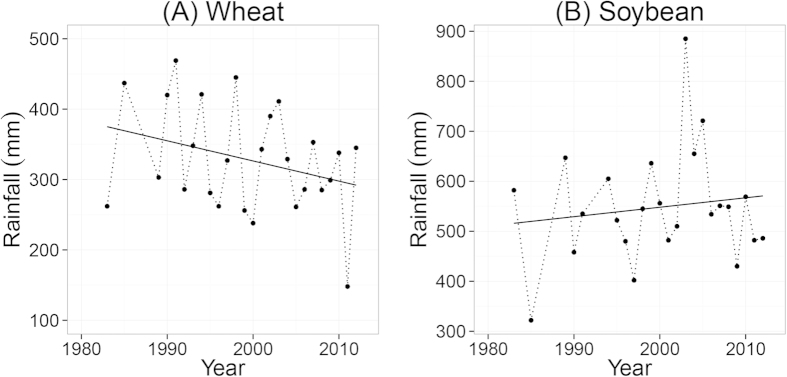
Total rainfall of the growing seasons of wheat (A) and soybean (B) during the period 1982–2012. Dots represent the amount of rainfall (mm) and solid lines show the trends.